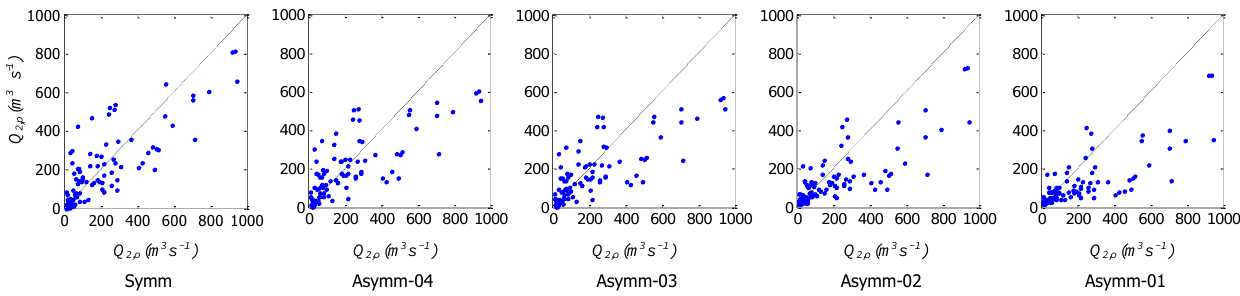
Figure 5. Scatter plots of the predicted ( y axis) vs. observed ( x axis) 2-year floods estimates on the independent test set of catchments, for the symmetric and asymmetric models.